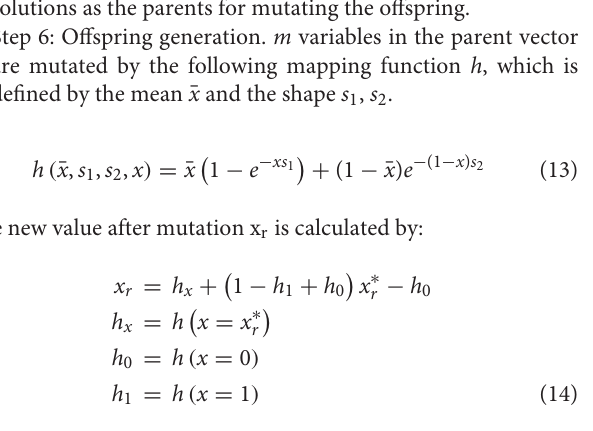
Frontiers in Energy Research |